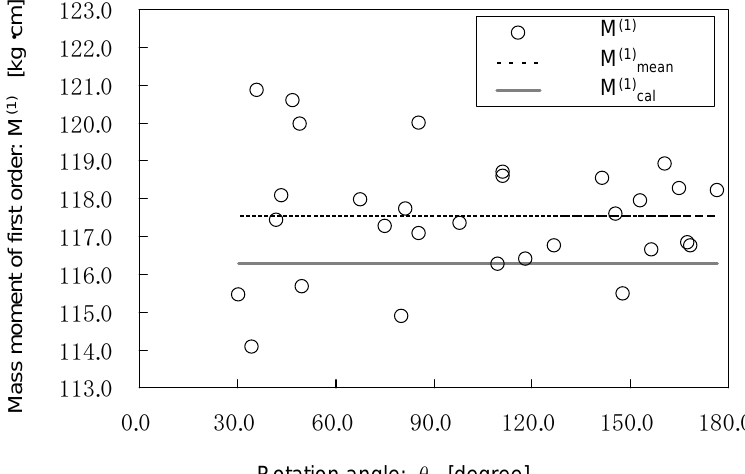
versus the rotation angle θ cal